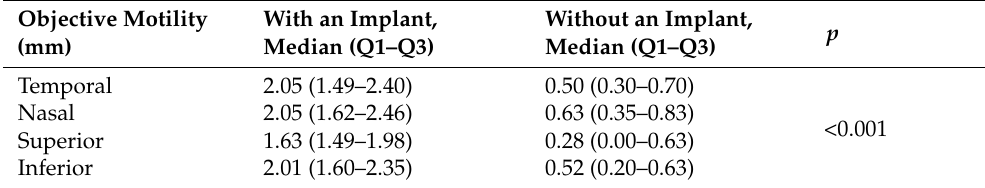
Table 5. Assessment of prosthesis motility in patients with and without an orbital implant.